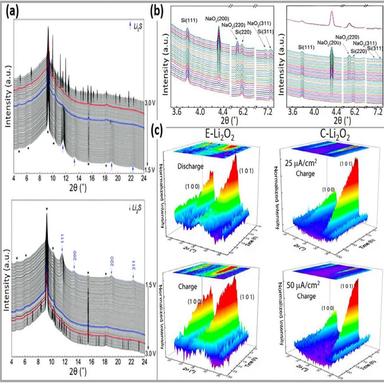
(a) operando XRD patterns of the Li-S battery during charging (up) and discharging (down) (Reproduced with permission from ref. Copyright 2013 Royal Society of Chemistry); (b) operando XRD graphs of a Na-O2 cell during the first discharge process using electrolytes of NaPF6 (left-side) and NaOTf (right-side) in diglyme (Reproduced with permission from ref. Copyright 2017 American Chemical Society); (c) 3D XRD plots of E-Li2O2 (left-side images) at 50 lA/cm2 and C-Li2O2 (right-sid